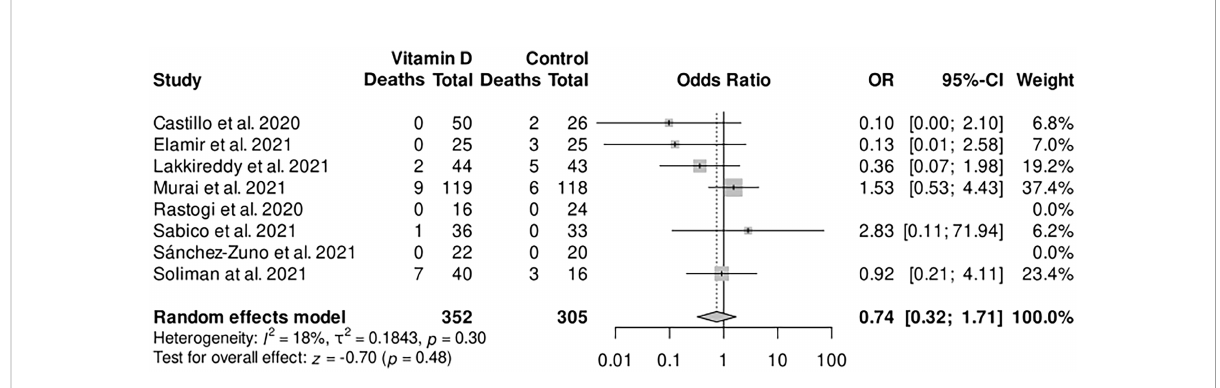
FIGURE 2 Forest plot random-effects model for the association of vitamin D supplementation and the main outcome mortality. CI, con fi dence interval; OR, odds